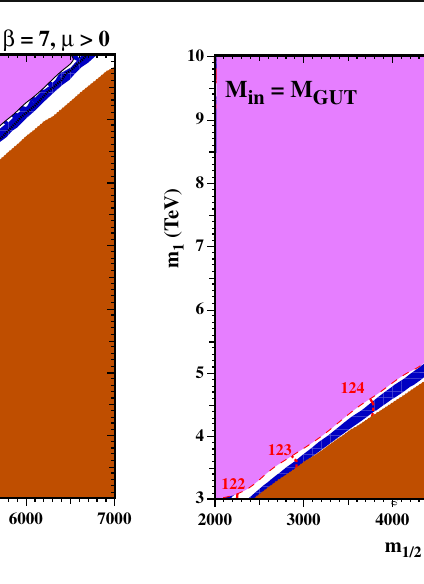
colors are the same as in Fig. 1. The width of the relic density region Fig. 2 Examplesof ( m 1 / 2 , m 1 ) planesfor M in = M GUT andtan β = 7 when both Higgs 5-plets are twisted. In the left panel , all the modular ( shaded blue ) has been enhanced for better visibility. The pink shaded region corresponds to parameter choices where the electroweak vac- weights α i = β i = 0, corresponding to A t , b = m 1 , A λ = 2 m 3 / 2 , A λ (cid:2) = 0, B H = 2 m 1 , and B (cid:3) = 0. In the right panel , the modular uum conditions cannot be satisfied and radiative electroweak symmetry weights are chosen to be α t , b = 1, α λ = 2, α λ (cid:2) = 0, β H = 2 and breaking is not β (cid:3) = 0, corresponding to A = B = 0. The shadings and contour 0 0